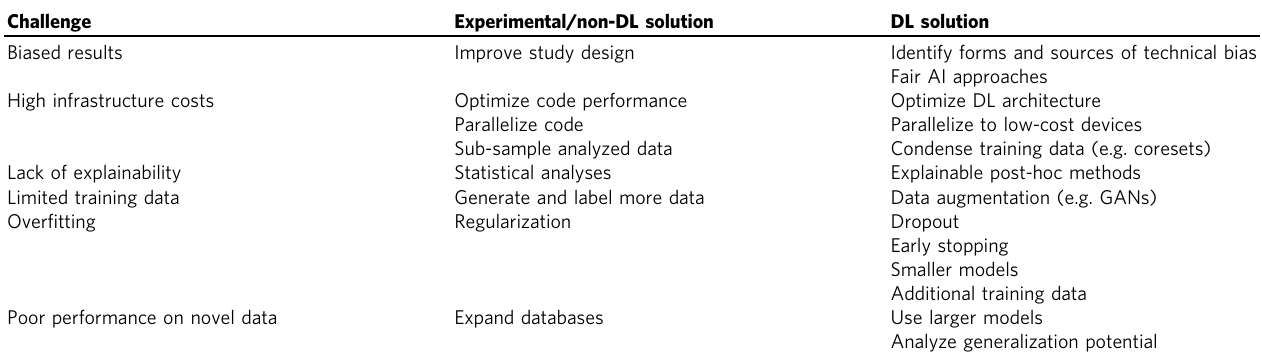
Table 2 Commonly faced challenges in computational biology and potential solution avenues when using